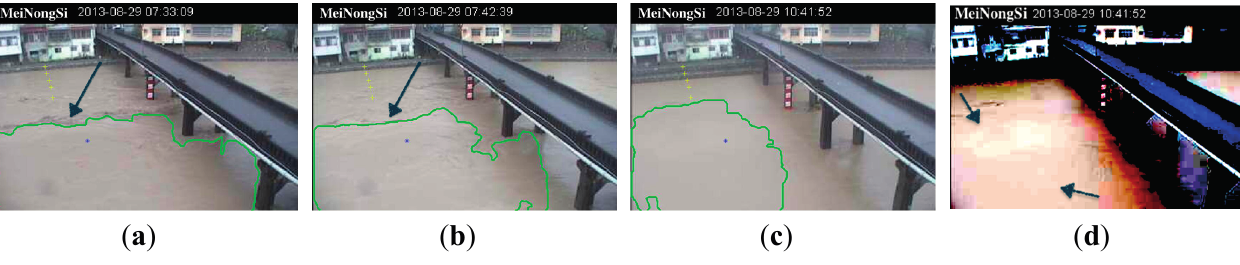
Figure 6. Images with false diagnoses. ( a – b ) boundaries are caused by wave of large turbulence, as indicated by the arrow; ( c ) result of signal loss that occurred during transmission and compression; and ( d ) result of contrast enhancement of ( c ) by 50